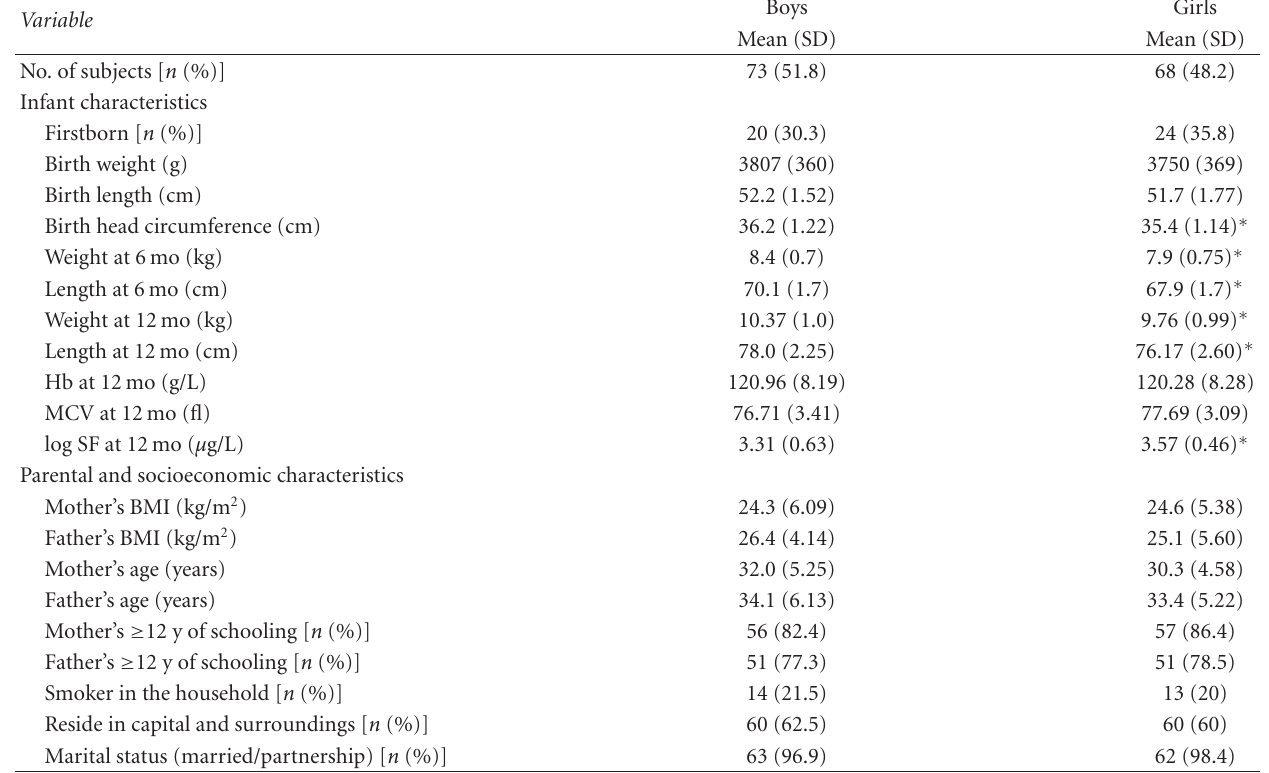
Table 1: Infant and parental characteristics of the